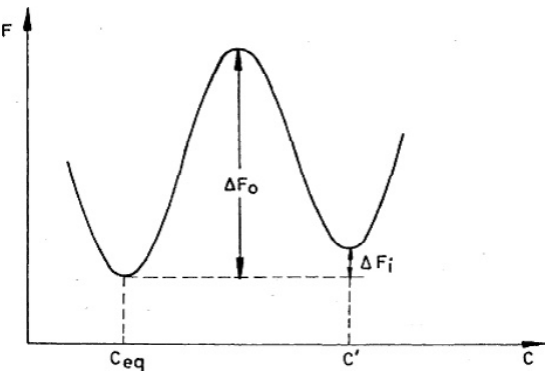
Fig. 1. Relationship between free energy, F and atomic configuration, C for unit of boundary sliding (see our work